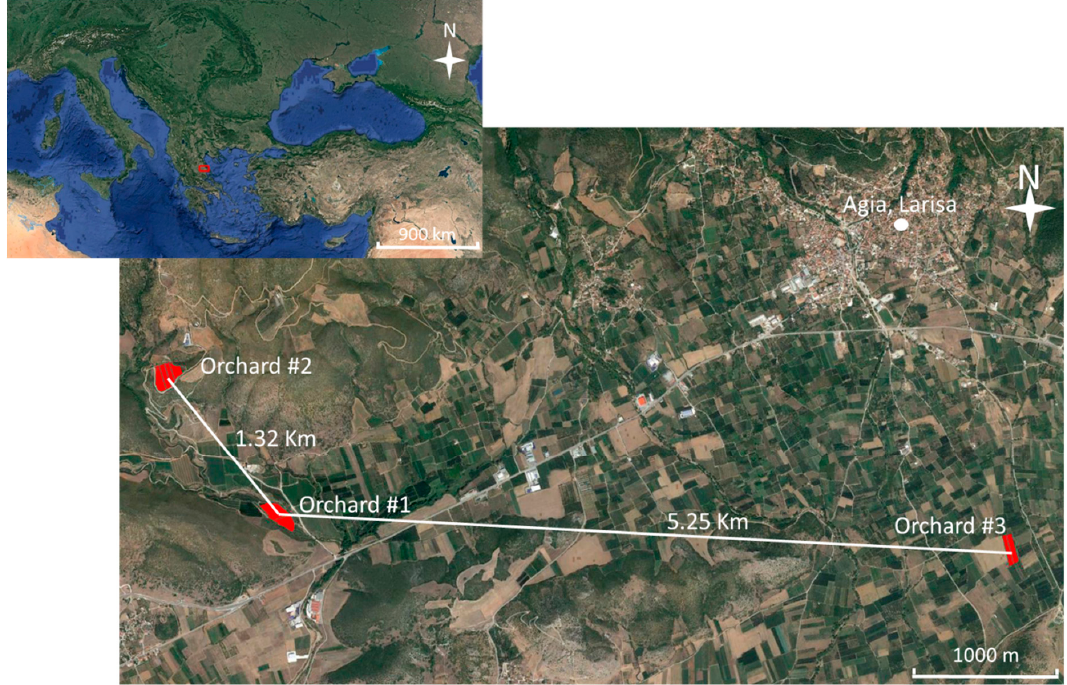
Figure 1. Geographic location of the experimental orchards in relation to the town Agia and distances between them in kilometers (satellite images cropped from Google Earth Pro). Table 1. Sweet cherry cultivars grown in different experimental plots. “DSS” plots were managed